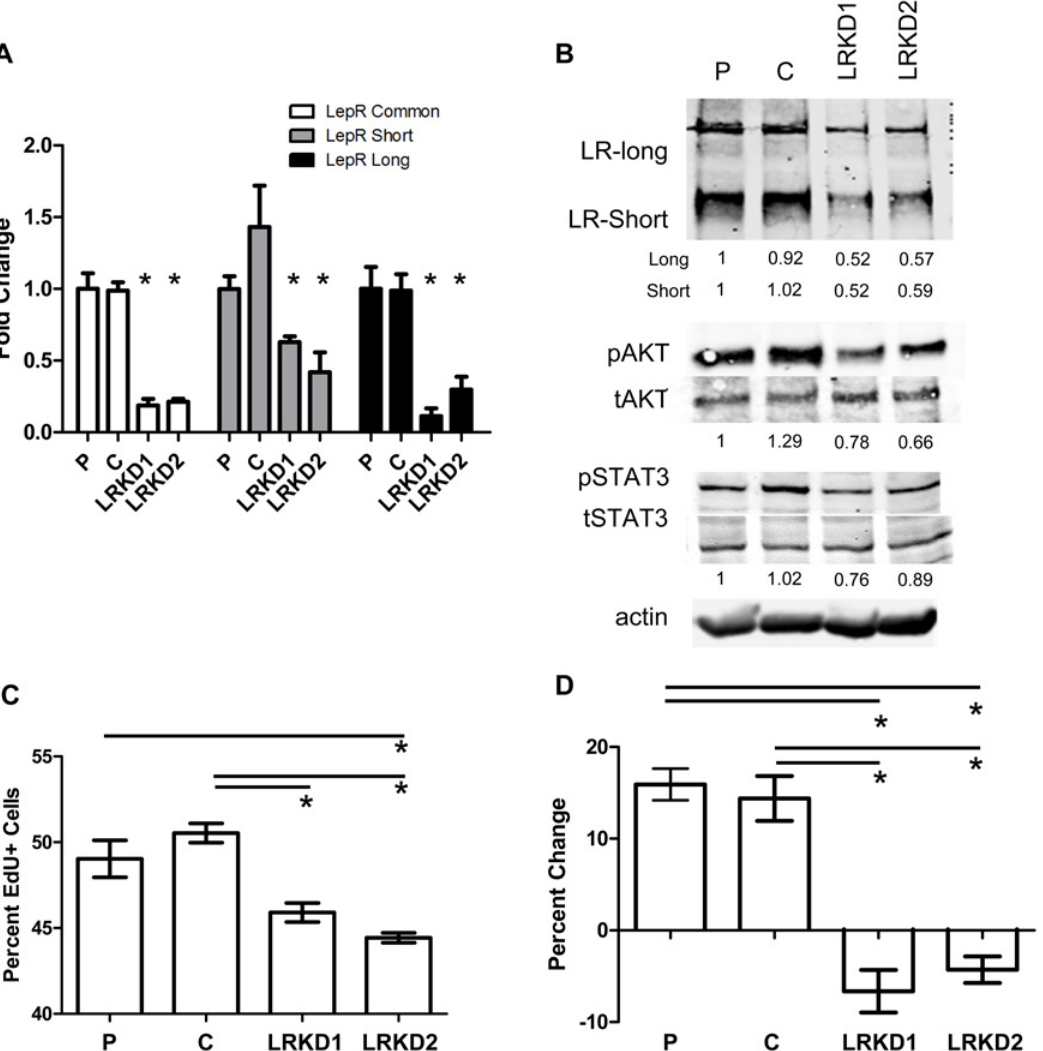
Fig 5. Knockdown of leptin receptor in pancreatic cancer cells leads to functional impairment of leptin signaling. Long and short leptin receptor RNA levels measured through realtime PCR analysis were both significantly decreased using two different shRNAmir lentiviral titers in the Panc02 cell line (A). Western and densitometric analysis confirmed leptin receptor knockdown as well as reduced activation of pAKT (B). Basal proliferation was significantly decreased in both the LRKD1 and LRKD2 knockdown cell lines when grown in serum free conditions (C). Stimulation with leptin at 50ng/mL induced proliferation in parental and control cells but failed to induce proliferation (percent change compared to untreated) in either of the knockdown cell lines compared to parental or control shRNA (D). Statistical analysis by ANOVA * represents p < 0.014 short, p < 0.0023 long, p < 0.0003 common (A); ANOVA p < 0.0008 (C).; ANOVA p < 0.0001 (D). * p < 0.05 in